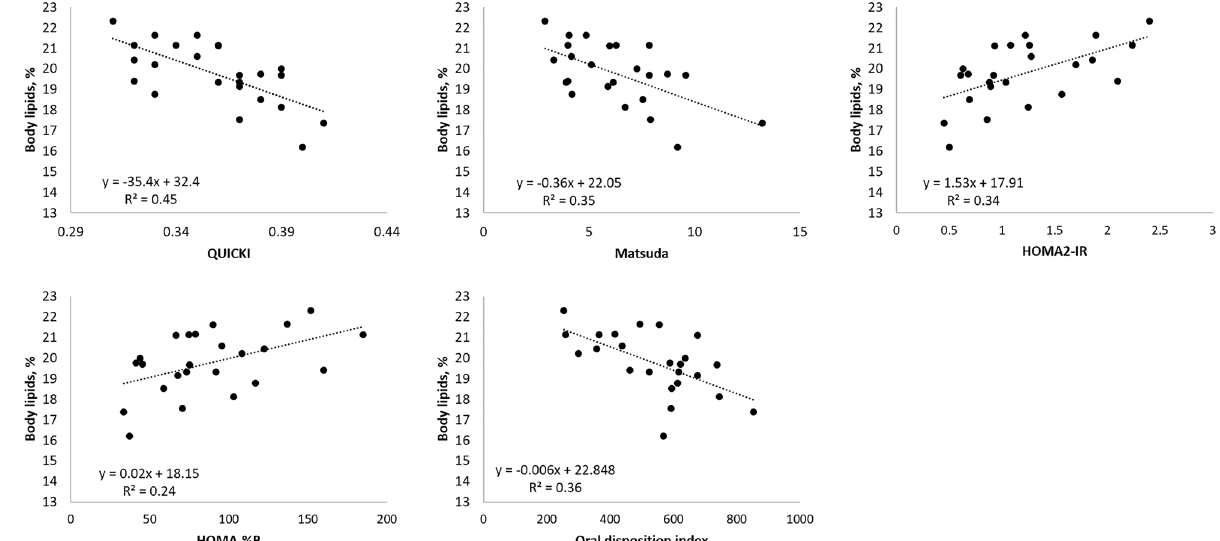
Figure 2. Linear regression among insulin sensitivity indexes and total body lipids (trial 1; n = 24). Only significant regressions with body lipids are presented in the figure ( P < 0.05). QUICKI quantitative insulin